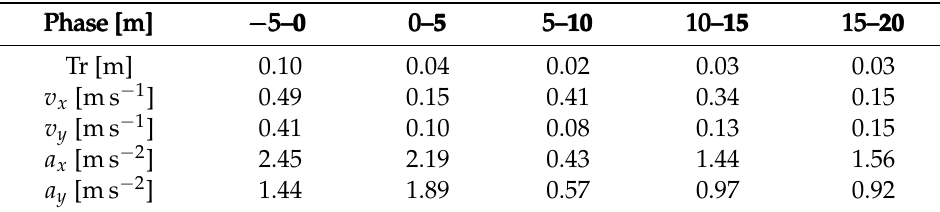
Table 2. Mean absolute error (MAE) for phases of 5m between the paired difference and zero difference (Figure 5b).